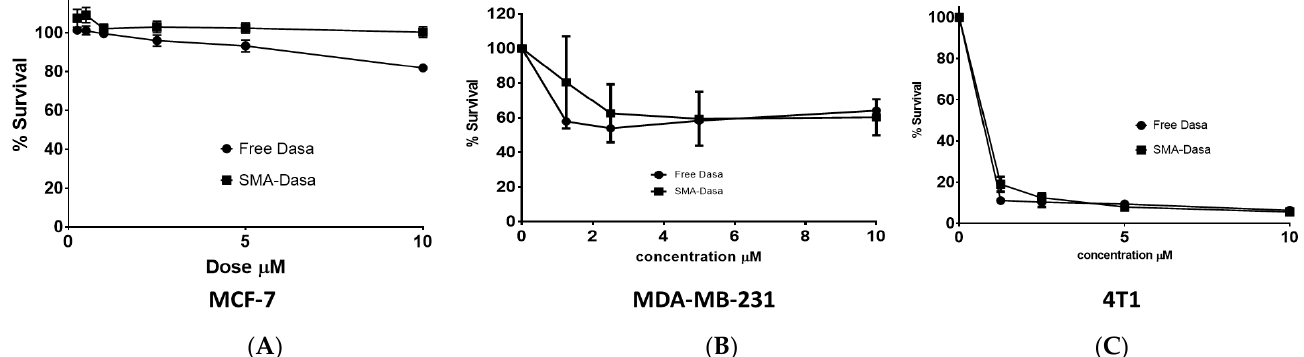
Figure 2. Cytotoxicity of dasatinib and SMA–dasatinib ( A ) against MCF-7, ( B ) MDA-MB-231, ( C ) and 4T1 cells. The cells were treated for 72 h with specific concentrations of dasatinib and SMA–dasatinib micelles. The cell number was determined using the SRB assay. Data are expressed as mean ± SEM ( n = 3). Table 2. Experimental IC 50 values (μM) of free dasatinib and SMA–dasatinib towards human MDA- MB-231, 4T1, and MCF-7 cells.